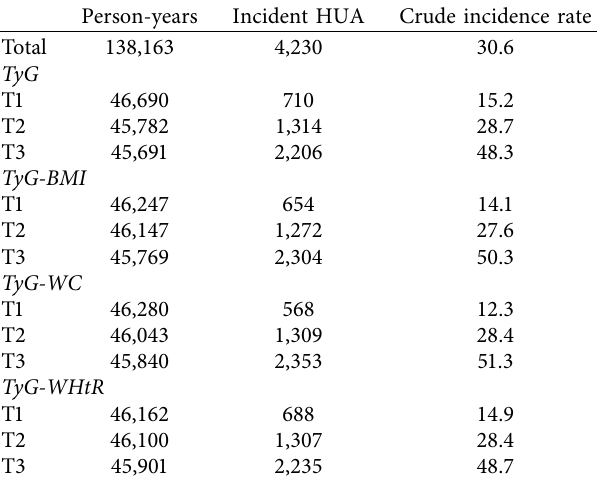
Table 2: The crude incidence rate of hyperuricemia categorised by the tertiles of TyG and its